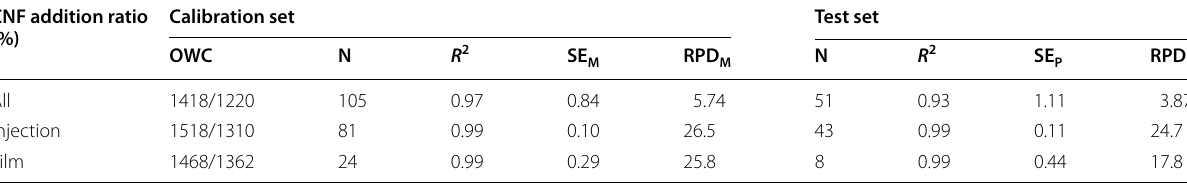
Table 3 The result of optimal wavelength combination (OWC) regression models for each sample